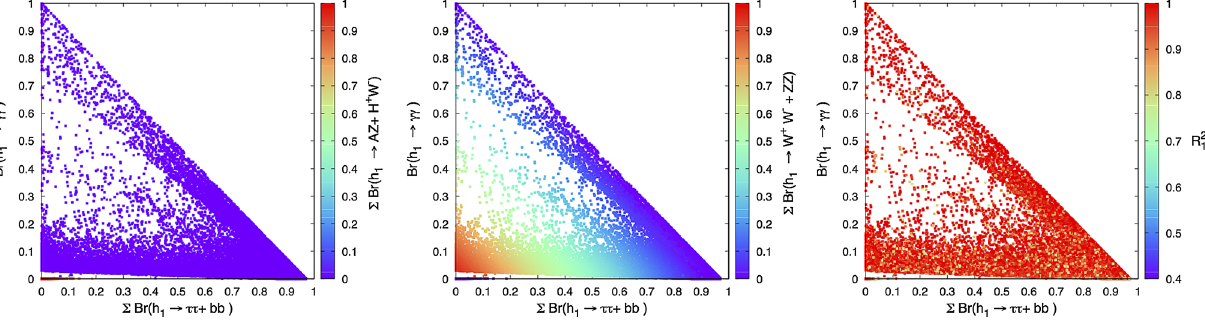
Fig. 3 Br ( h 1 → γγ) as a function of Br ( h 1 → τ + τ − + bb ) vs. Br ( h 1 → ( H ± W ∓ + AZ ) (left panel), Br ( h 1 → W + W − ) (middle panel) and R 2 (right panel) at 11